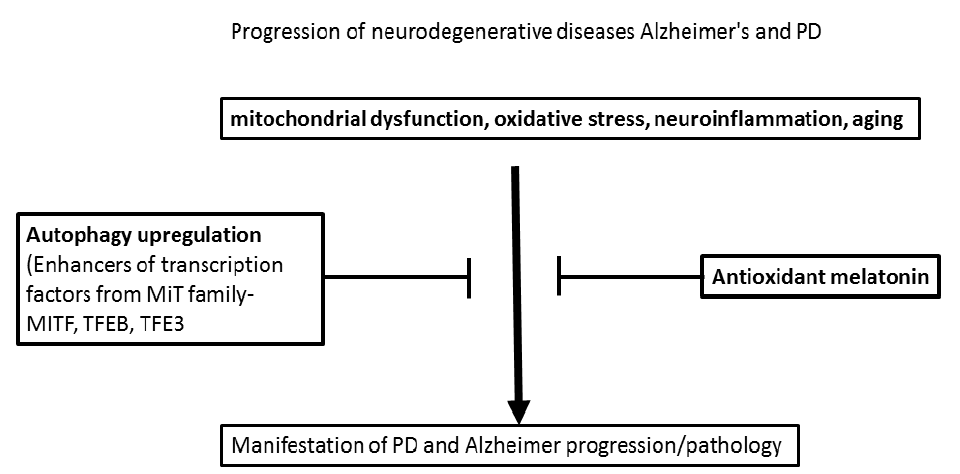
Figure 1. Molecular mechanisms which can reverse or delay the development of Alzheimer and PD pathology.